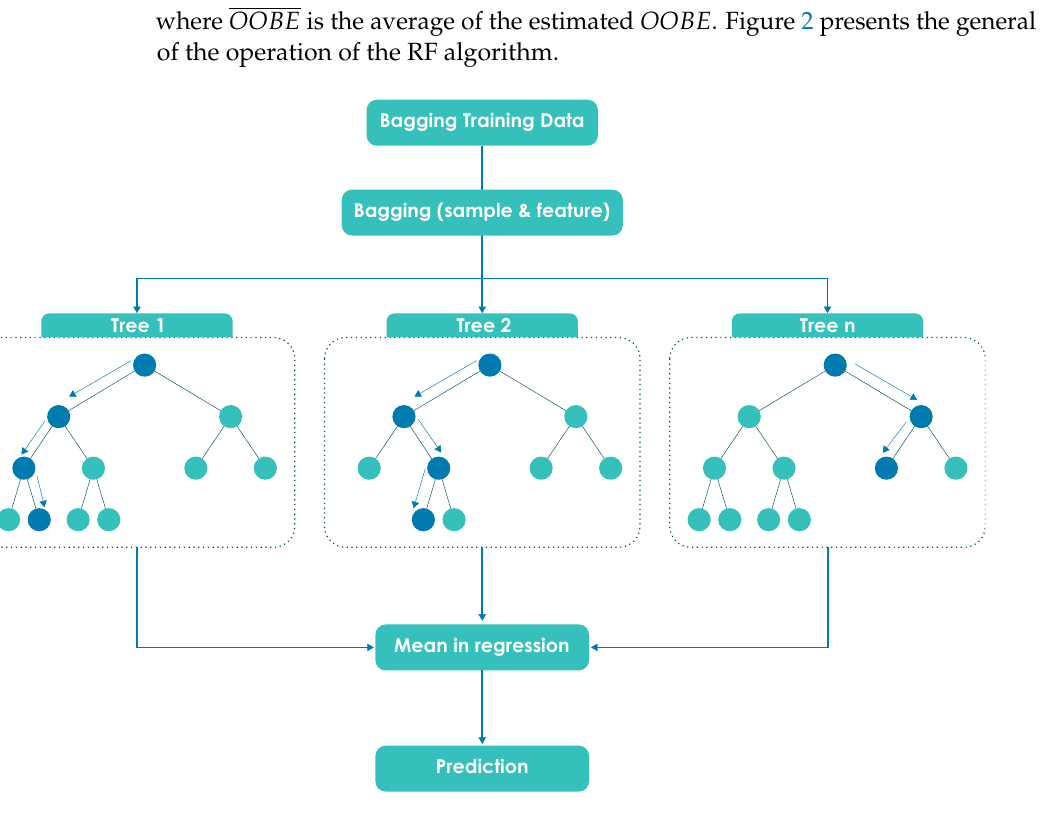
Figure 2. Random Forest regression